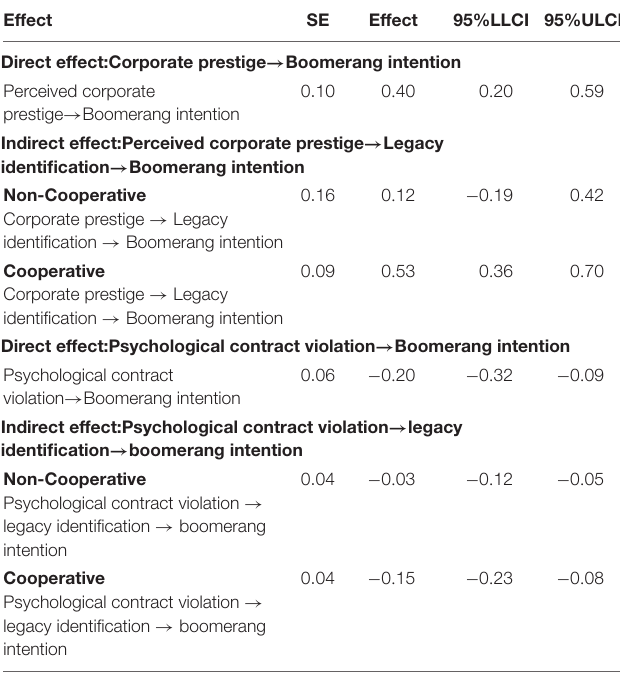
TABLE 5 | Results of the moderated mediating